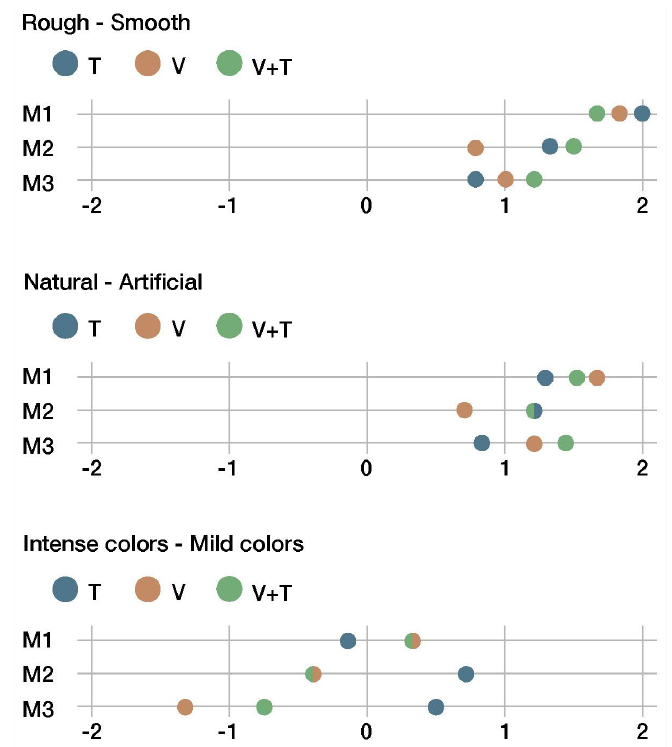
Figure 14. Third cluster of sensorial properties.